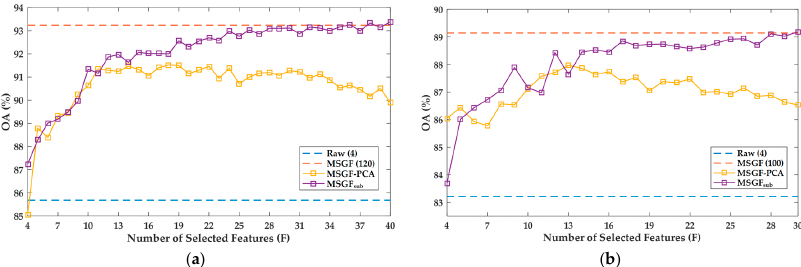
Figure 11. Comparison of the classification accuracy with feature selection and without feature selection: ( a ) results on Zh1 and ( b ) results on Zh2.